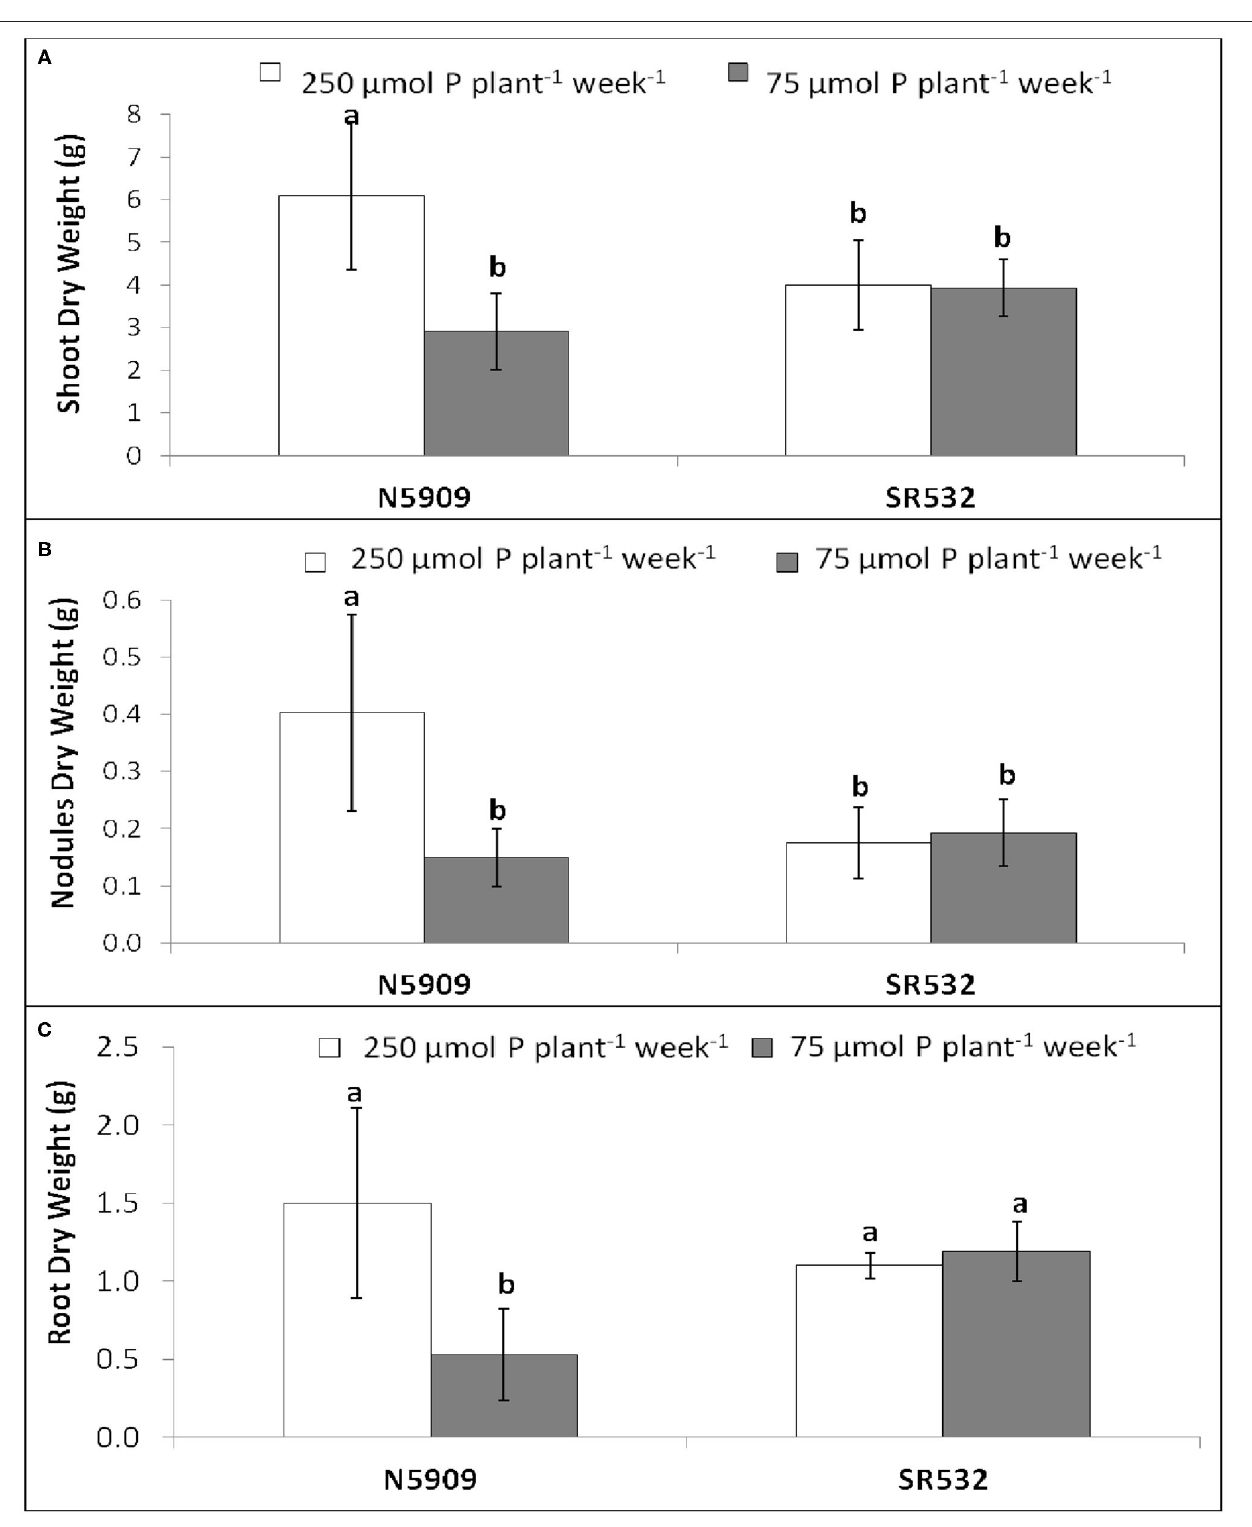
FIGURE 2 | (A) Shoot dry weight, (B) nodules dry weight, and (C) root dry weight of G. max cultivars N5909 and SR532 inoculated with B. elkanii SEMIA 587 under P sufficiency (250 µ mol P plant − 1 week − 1 ) (white) vs. P deficiency (75 µ mol P plant − 1 week − 1 ) (gray). Data represent average and standard deviation of ten replicates harvested at 42 DAT. Treatments with a common letter are not significantly different ( p >